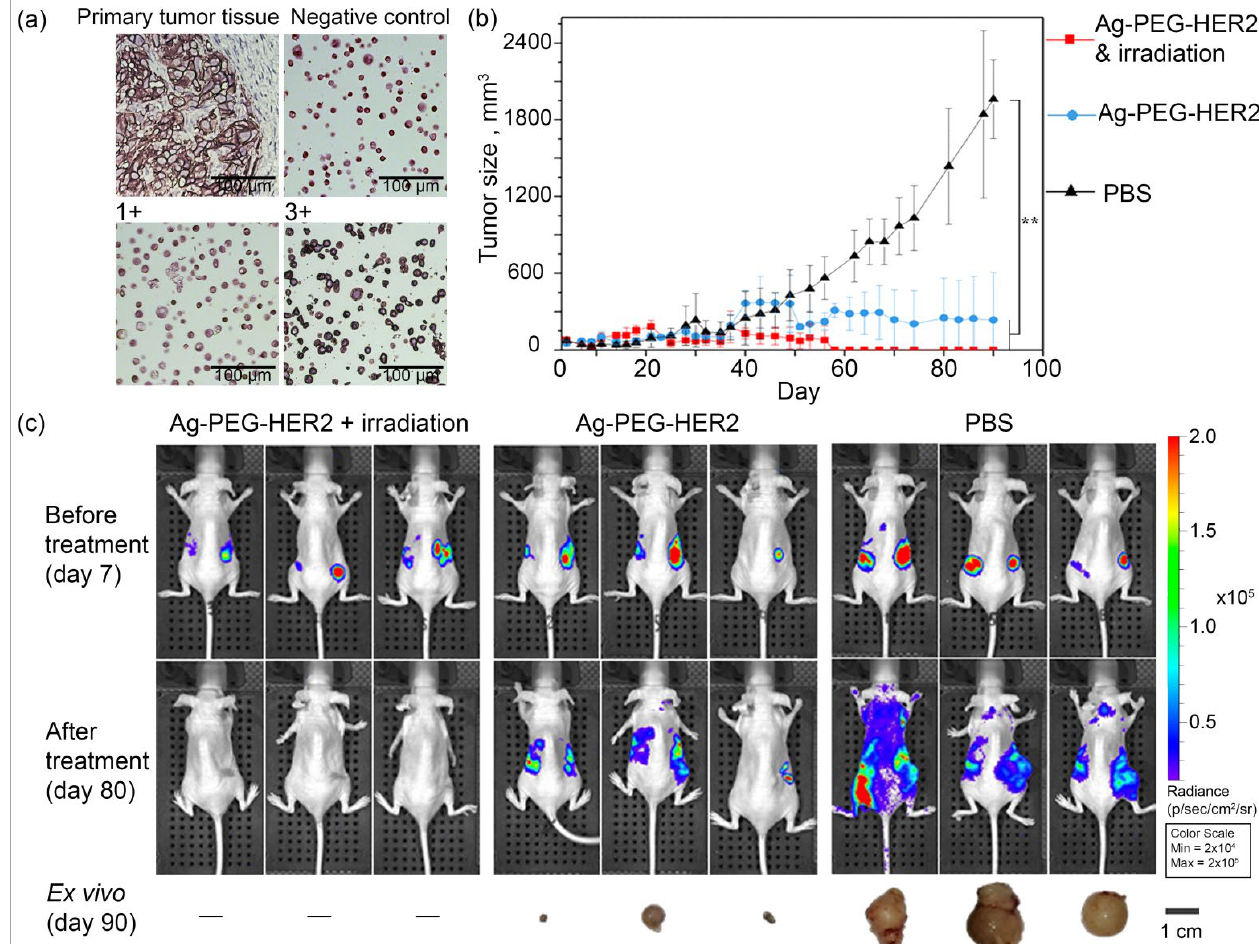
Figure 7. PTT of xenograft tumors with targeted Ag-PEG-HER2 nanoparticles and light irradiation. ( a ): Immunohistochemistry of BT/NanoLuc primary tumor tissue and HercepTest controls: negative control (0), normal HER2 expression (1+), and HER2 overexpression (3+) (scale 100 µ m). ( b ): Dynamics of BT/NanoLuc tumor growth under the treatment with repeated injections of PBS, Ag-PEG-HER2 nanoparticles, and Ag-PEG-HER2 with 1 h post blue light irradiation (n = 3 for each group), ** p < 0.05. ( c ): Bioluminescent imaging of BT/NanoLuc xenograft tumors before treatment (day 7 after inoculation) and after treatment (day 80) and ex vivo imaging of primary tumors (day 90). Mice were divided into three groups and treated with injections of (i) group